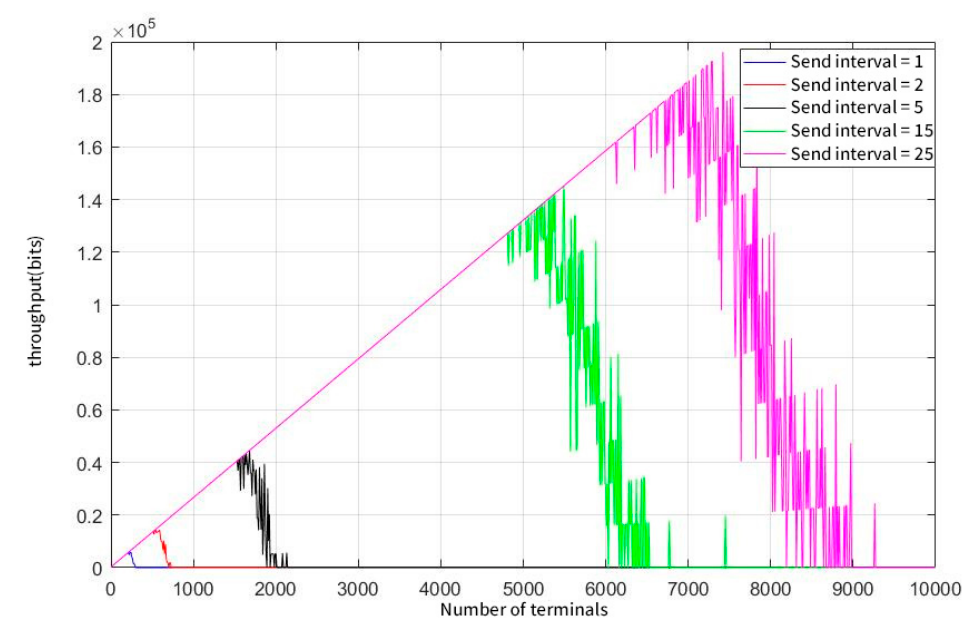
Figure 12. System throughput at a concurrent demodulation threshold of 200.